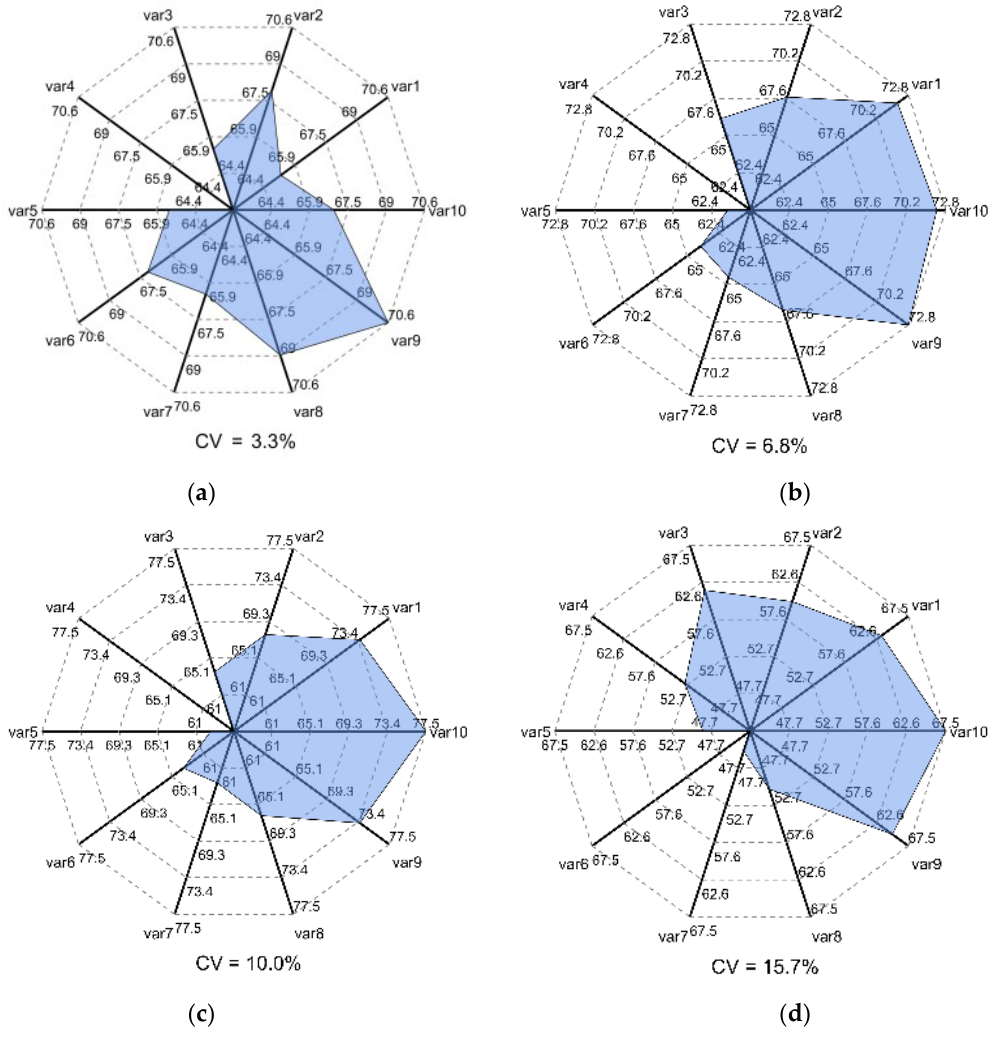
Figure 8. Displacement and variation coefficient of each outlet corresponding to different R/D ratios. ( a ) R/D ratio is 0.5; ( b ) R/D ratio is 1; ( c ) R/D ratio is 1.5; ( d ) R/D ratio is 2.